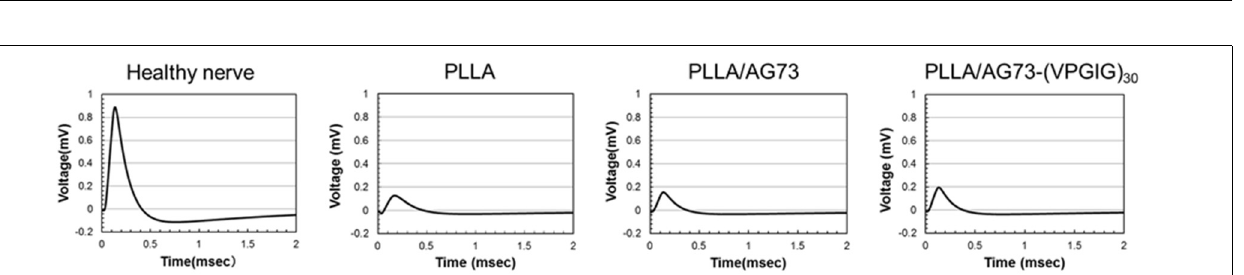
Table 1 | Peak time and intensity of active potentials determined using electrophysiological analysis.